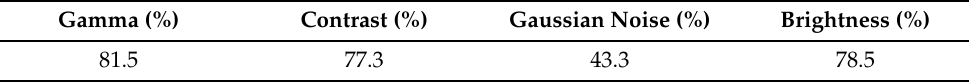
Figure 16. Algorithm robustness assessments with image adjustments. Table 4. Proportion of gauges correctly read for each image